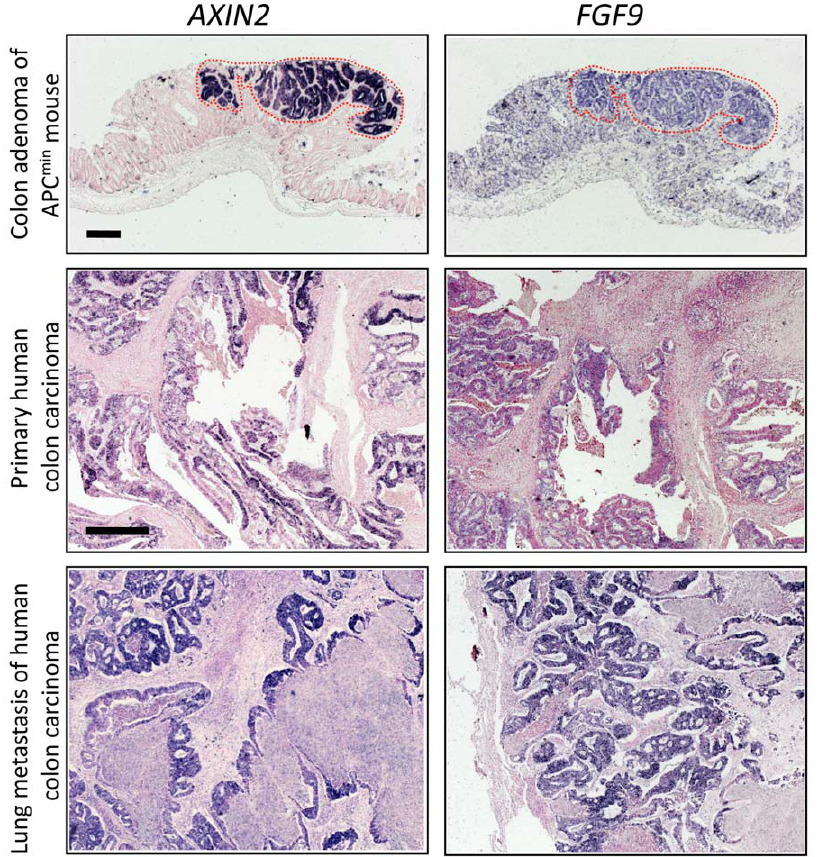
Figure 6. FGF9 is expressed in mouse and human intestinal malignancies. Expression of the Wnt target gene Axin2/AXIN2 (to the left) and Fgf9 / FGF9 (to the right) in mouse and human intestinal malignancies was determined by RNA in-situ hybridization. Upper panels: Adenoma of the colon from an APC min mouse. Middle panels: primary human colon carcinoma. Lower panel: lung metastasis of human colon carcinoma. Negative control hybridization (using an unrelated asRNA probe of similar size and CG content, not shown) did not produce a signal. Scale bars represent 500 m m.